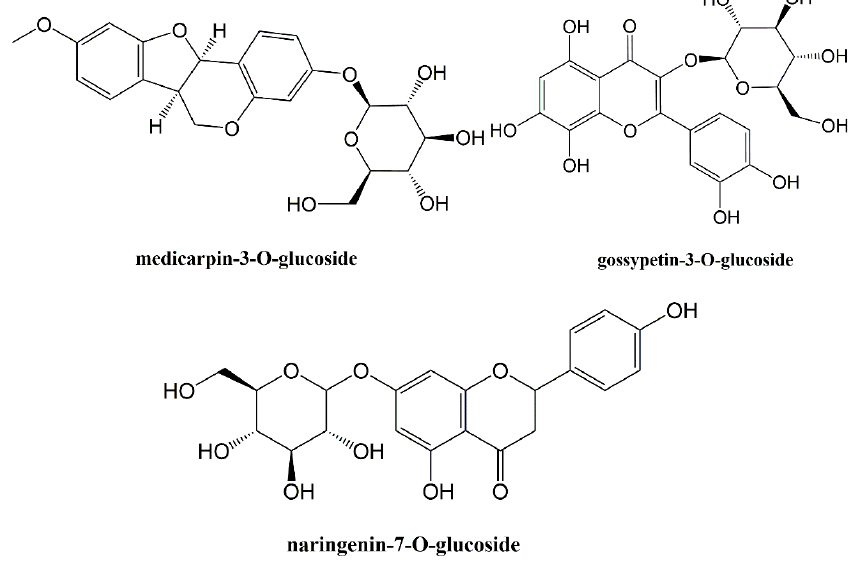
Figure 1. Chemical structures of isolated compounds.